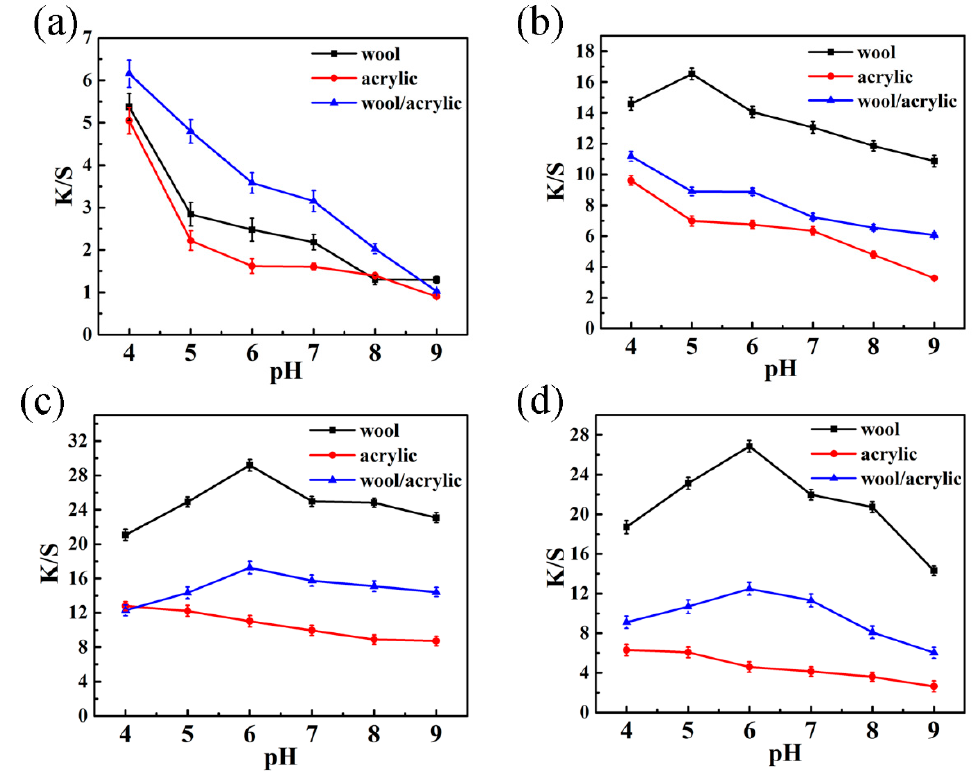
Figure 7. Effect of pH on K/S for heterocyclic reactive dyes. ( a ) Dye 1; ( b ) Dye 2; ( c ) Dye 3; ( d ) Dye 4.